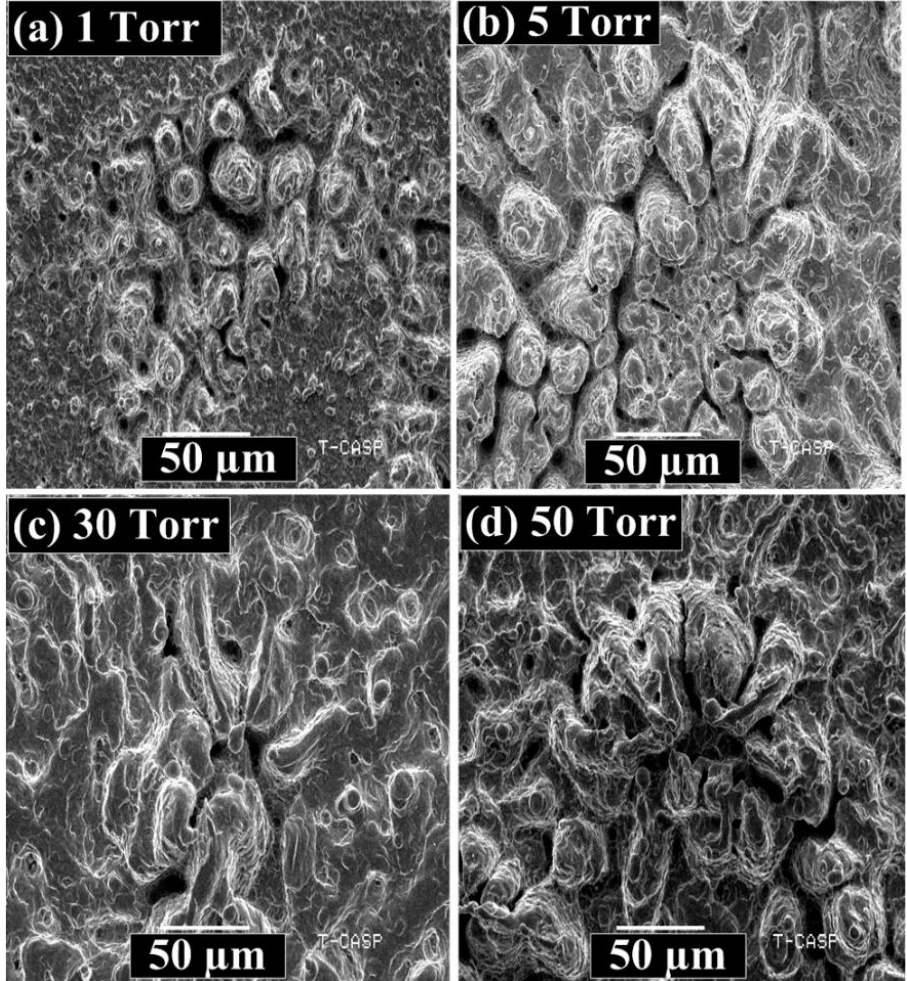
Figure 12. SEM micrographs exhibiting the variation in surface morphology under an ambient environment of Ne at different pressures, viz., ( a ) 1 torr, ( b ) 5 torr, ( c ) 30 torr, and ( d ) 50 torr, with a laser irradiance of 3.8 GW/cm 2 in the field-free case.